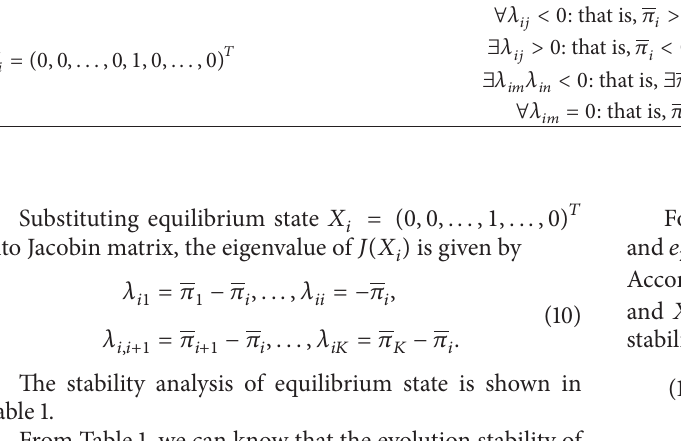
Table 1: The local stability analysis of equilibrium state 𝑋 𝑖 = (0,0, ...,1, ...,0) 𝑇 . Equilibrium point Condition for characteristic root